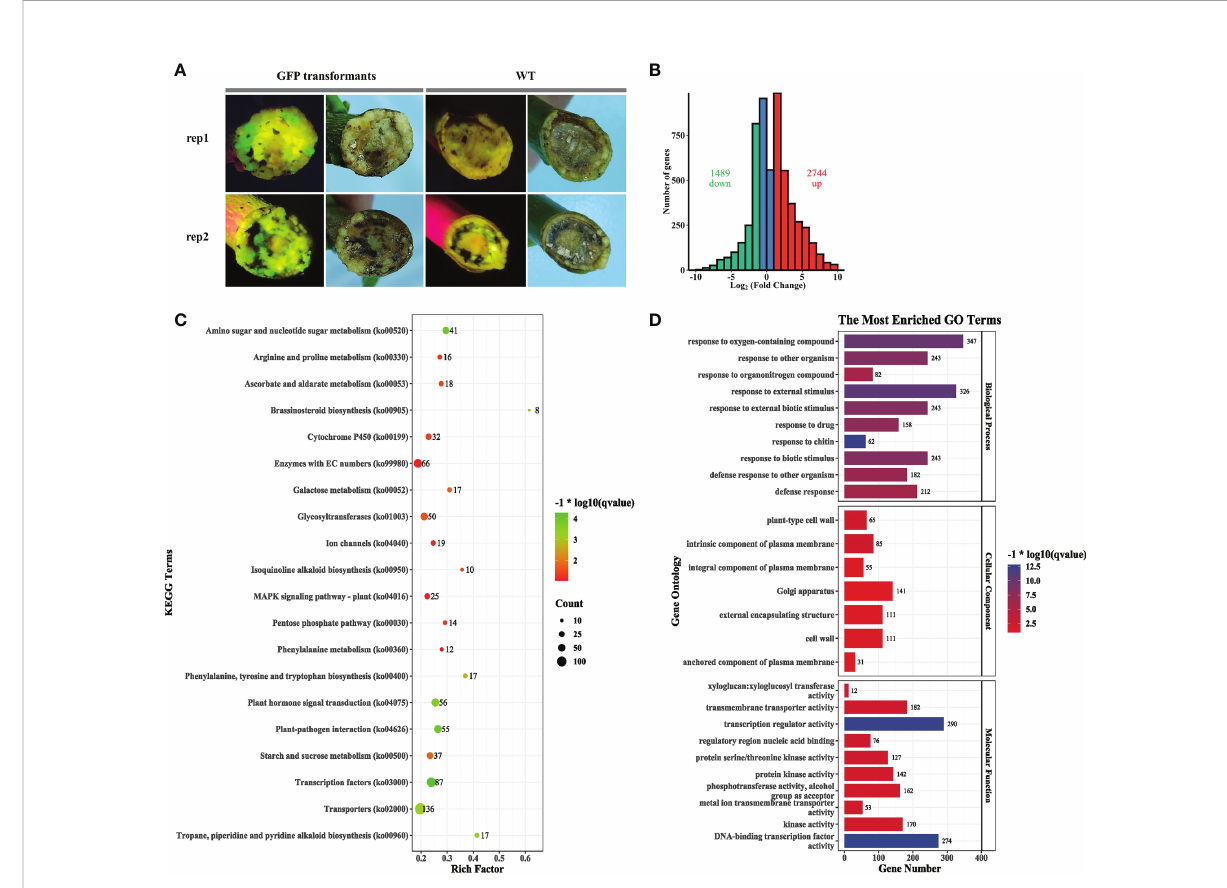
FIGURE 4 Agrobacterium rhizogenes K599 signi fi cantly affects expression of genes involved in hormone signal transduction. (A) Phenotype of callus generated on the wound surface of explants 2 weeks post-agroin fi ltration. (B) Volcano plot (left) and histogram (right) of callus 2 weeks post- agroin fi ltration compared with the wild type. (C) KEGG pathway analysis of differentially expressed genes (DEGs). The count represents the numbers of DEGs annotated for the pathway term. The q value is the adjusted p value. (D) Gene ontology (GO) enrichment analysis of DEGs. The results are summarized for the three GO categories (cellular component, molecular function, and biological process). The x -axis represents the number of DEGs in a category; the y -axis represents the GO